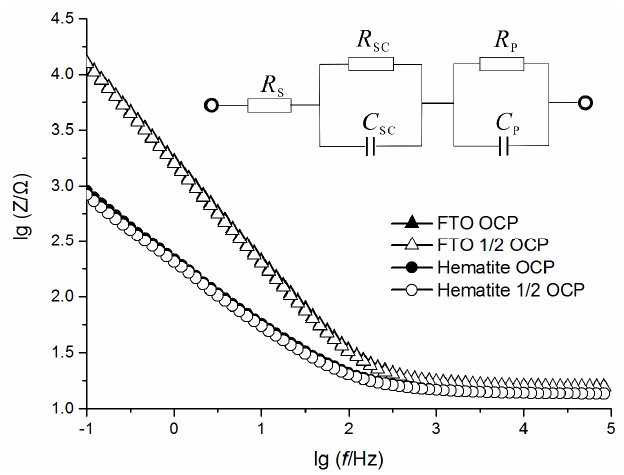
Figure 7. Electrochemical impedance spectroscopy of hematite-FTO and FTO electrodes. Open Current potential (OCP).